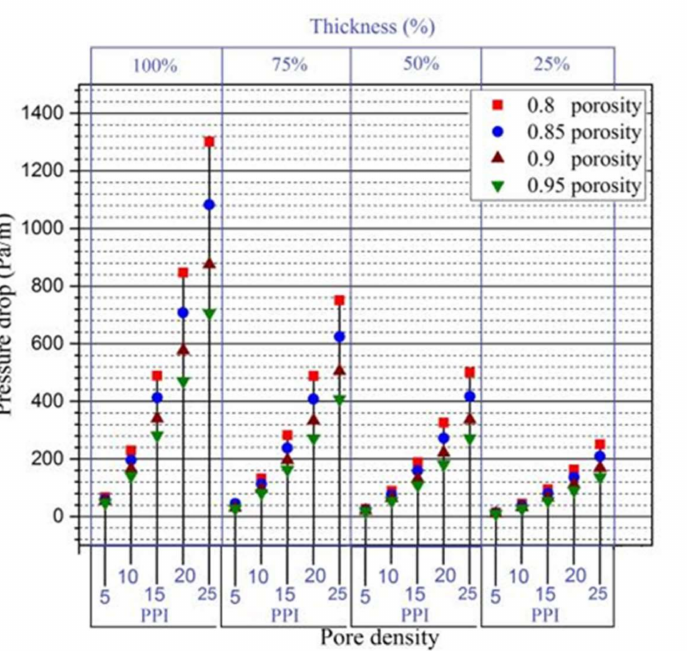
Figure 5. Variation of pressure drop for varying thickness scenario at various pore density and porosity